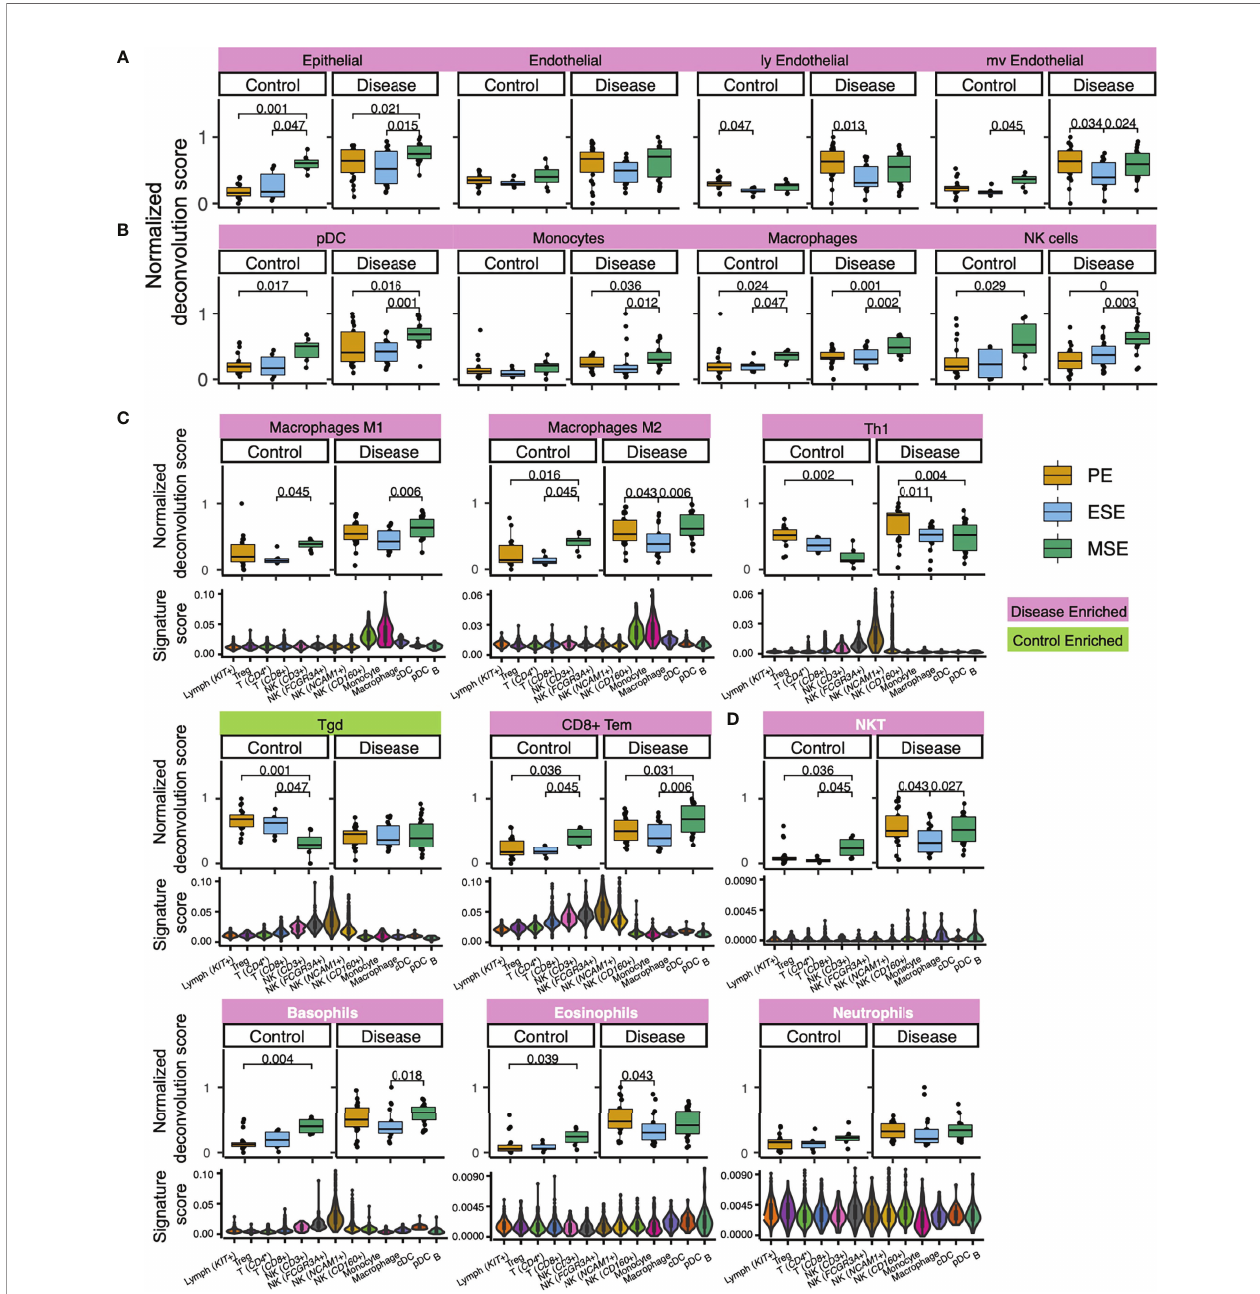
FIGURE 5 | Deconvolution results and signature score distribution in single-cell data of select xCell signatures (A) with con fi rmed speci fi city to major endometrial non-immune cell types, (B) with con fi rmed speci fi city to endometrial immune cell types, (C) that are function specifying, and (D) lack representation in healthy endometrium but show endometriosis-associated statistically signi fi cant abundance increase. Signi fi cant p-values are marked on the fi gure. Signatures in panel (D) are colored in white. For violin plots in (C, D) , each violin represents an immune cell type/subtype identi fi ed via immune-only scRNAseq analysis on healthy endometrium ( Figure 3 ). Signature score was calculated as the ratio between transcripts (UMI) that encode genes in the xCell signature to all transcripts (UMI) detected in each single cell ( Materials and Methods